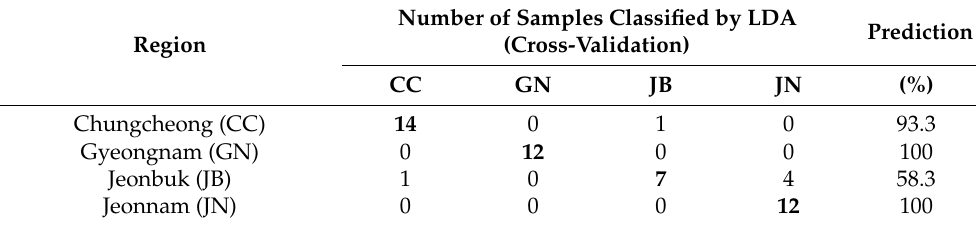
Table 5. Predicted geographical origins of clams from different provinces of Korea. Numbers of individual clams with geographical origins determined by LDA of carbon isotope ratios of fatty acids ( δ 13 C-FA). Each number represents a sample classified according to the predicted region; pre- diction was performed using the number of samples (bolds) whose origin was well-identified out of the total number of samples. The results are evaluated using cross-validation.